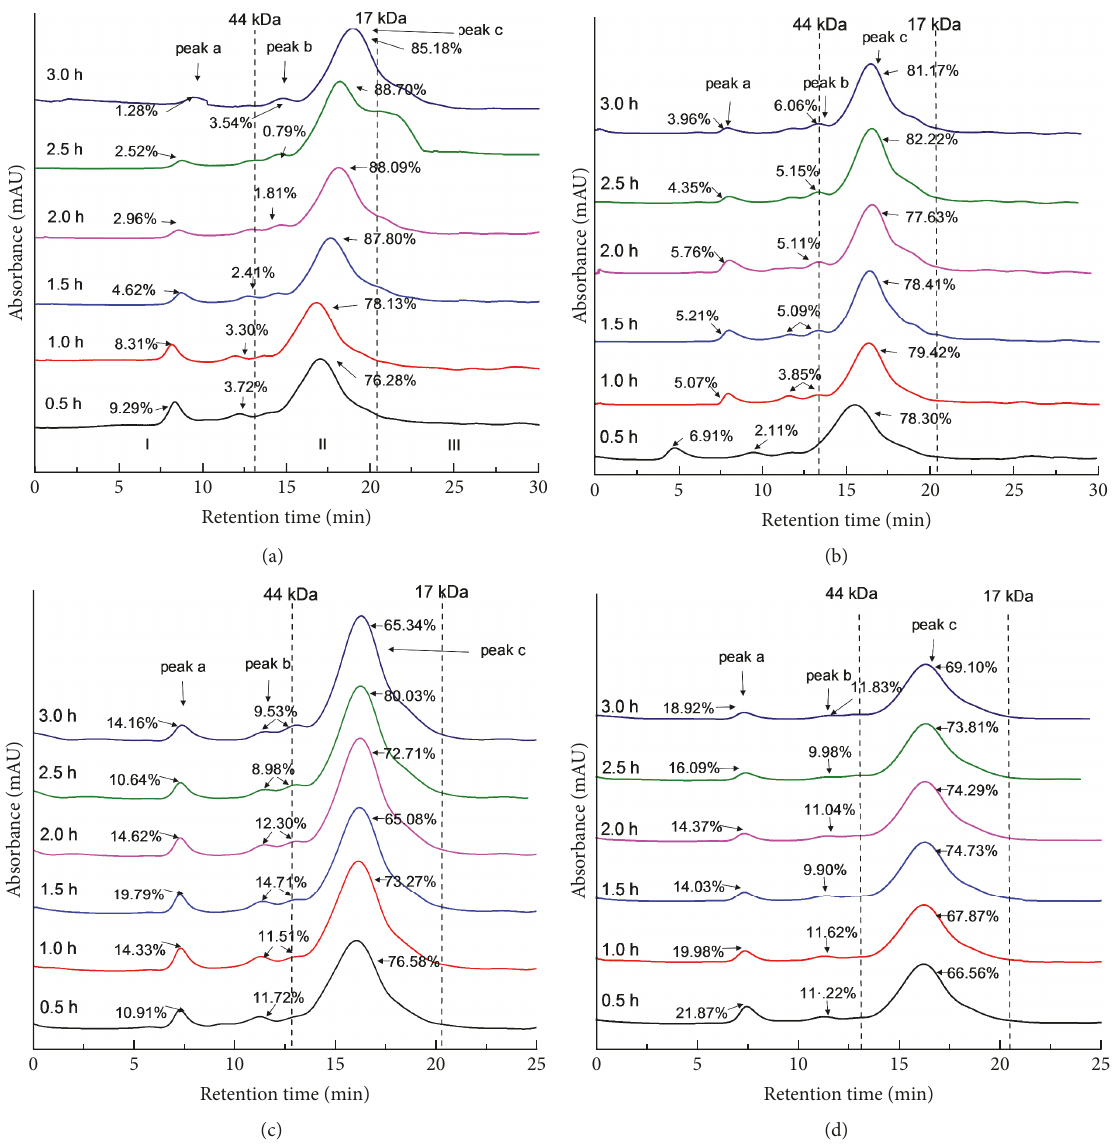
Figure 3: Molecular weight distributions of untreated and extruded HSPP samples: (a) nonextruded, (b) Ex60-HSPP, (c) Ex80-HSPP, and (d)